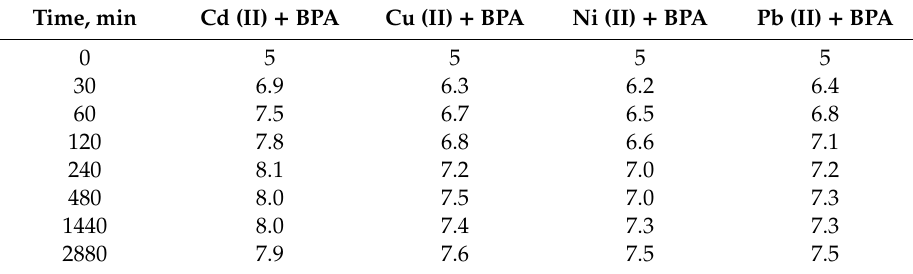
Table 7. pH evolution on simultaneous adsorption